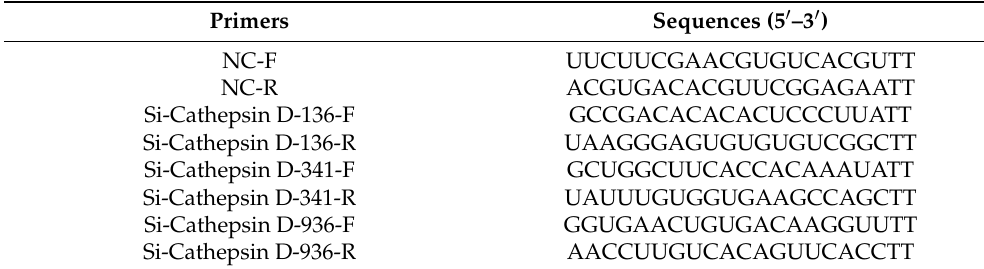
Table 1. Primers used for silencing Ec-Cathepsin